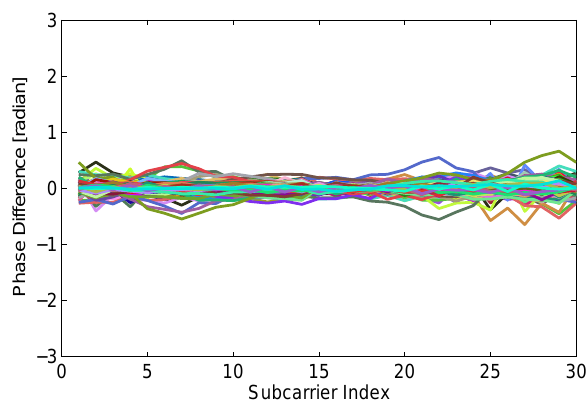
Figure 7. Stable phase difference in the static state.